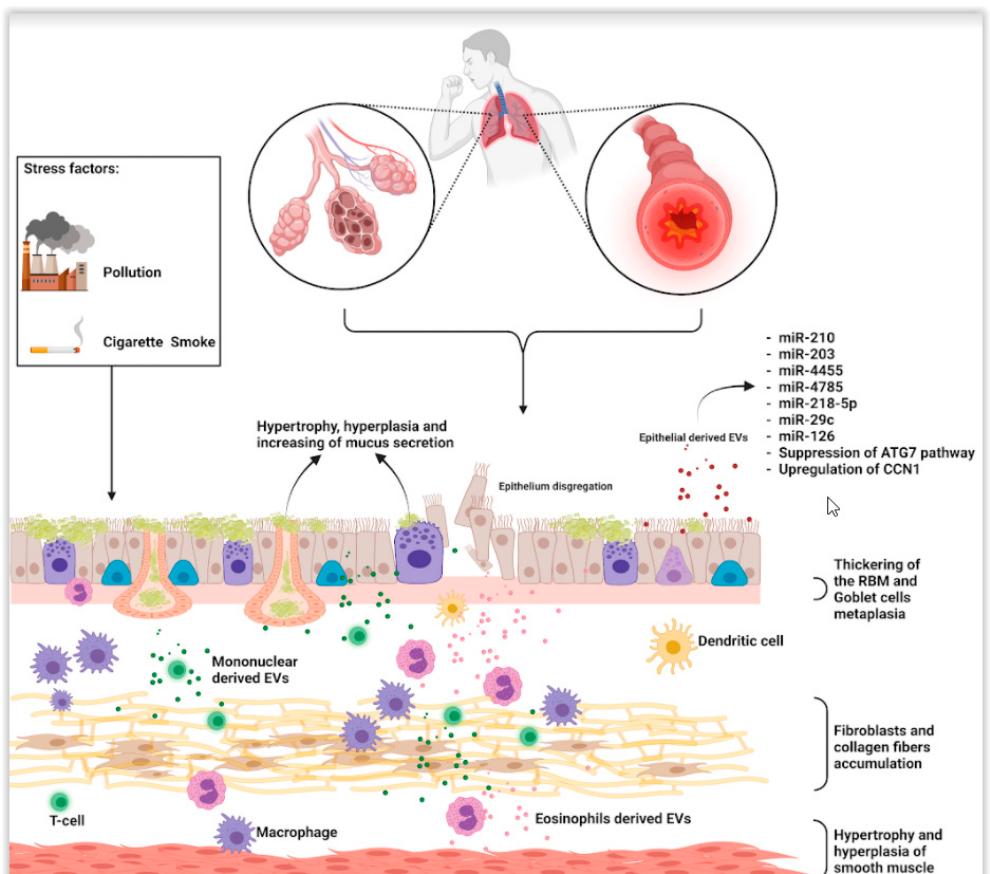
Figure 2. Scheme of COPD pathogenesis. Chronic external stimuli generate massive deregulation of lower airways. Chronic external stimuli generate massive deregulation or lower airways. EVs mediate these tissue changes directly and indirectly. Their production is also increased by the perennially present phlogistic status established with the progress of the pathology. The immune cell component contributes greatly to the release of EVs that affect all cell populations of the respiratory mucosa.